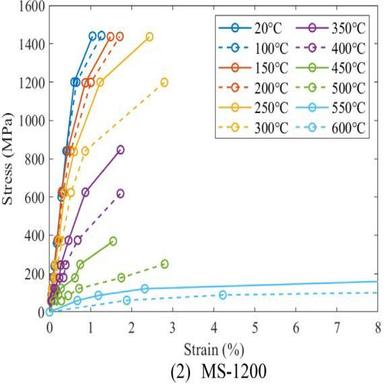
Stress-strain curves obtained from transient-state tests.